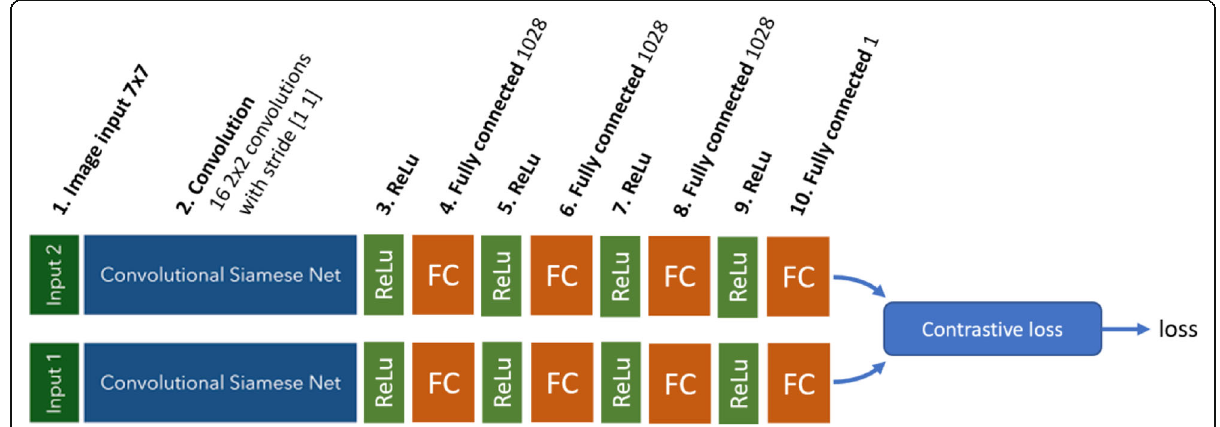
Fig. 3 Selected Siamese network architecture for dimensionality